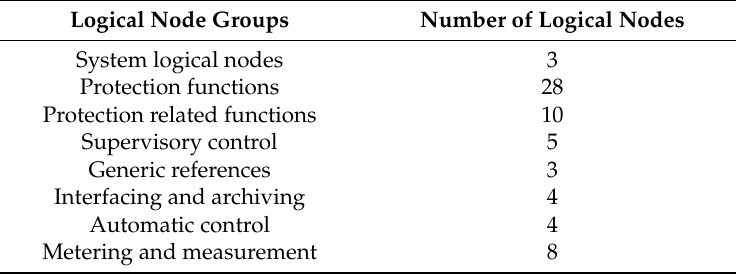
Table 1. IEC 61850 logical node (LN) groups [16].